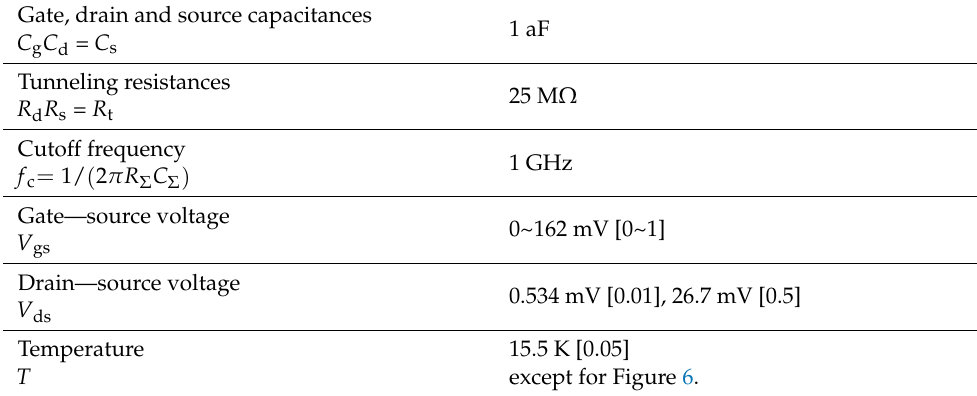
Table 1. The simulation